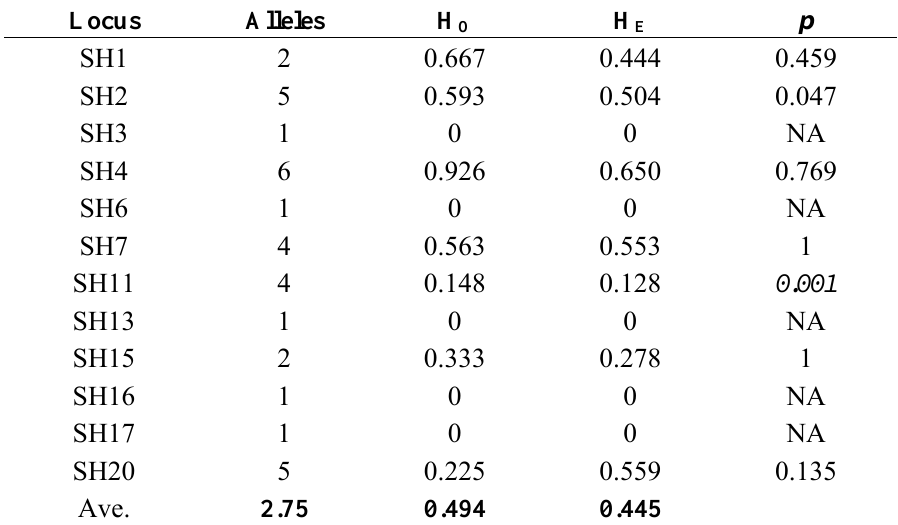
Table 2. Number of alleles, observed and expected heterozygosity and Hardy Weinberg p value for 12 leafy seadragon